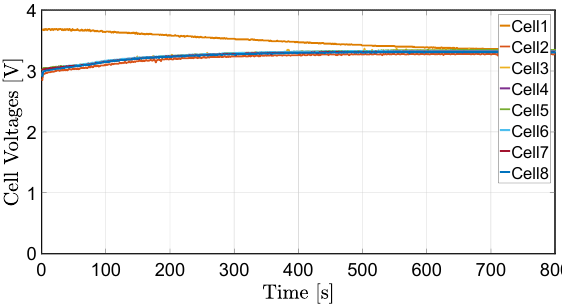
Figure 17. The cell voltage waveforms of the proposed circuit (cell 1 to cell